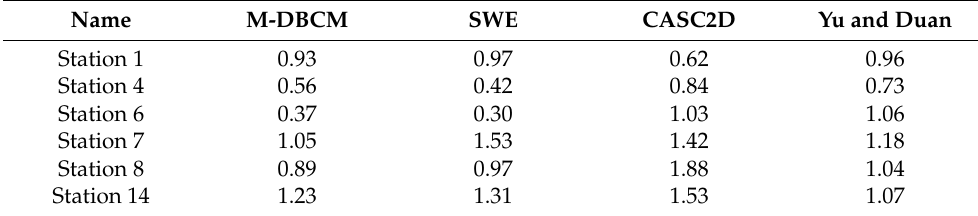
Table 3. RMSE of the solutions of the Goodwin Creek